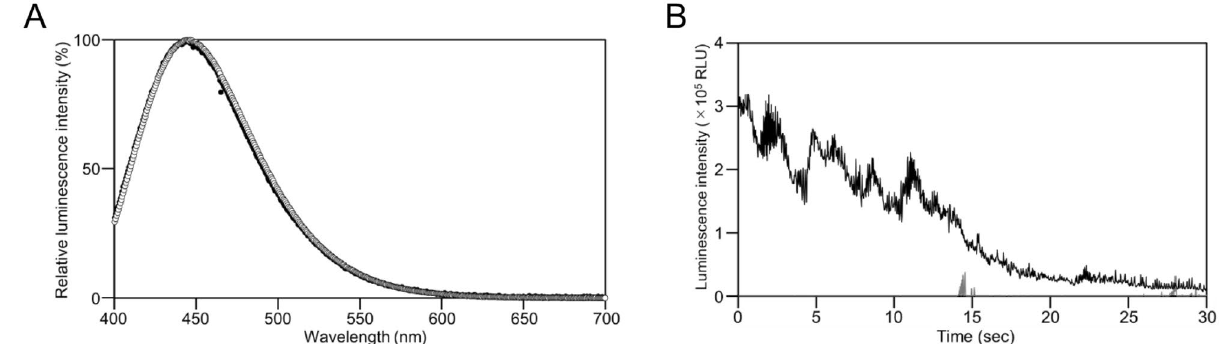
Figure 2. Luminescence spectra and KCl-induced light emission of Polycirrus sp. ISK. ( A ) Spectrum analysis of Polycirrus sp. ISK using a living worm stimulated by an electric shock. The luminescence spectra were obtained from two different individuals. The λ max represented in closed circles and open circles were 444 nm and 446 nm, respectively. ( B ) Typical light-emission signal of a living worm soaked in 667 mM KCl. The black line indicates luminescence intensity after adding KCl solution, and the gray line indicates luminescence intensity before adding KCl